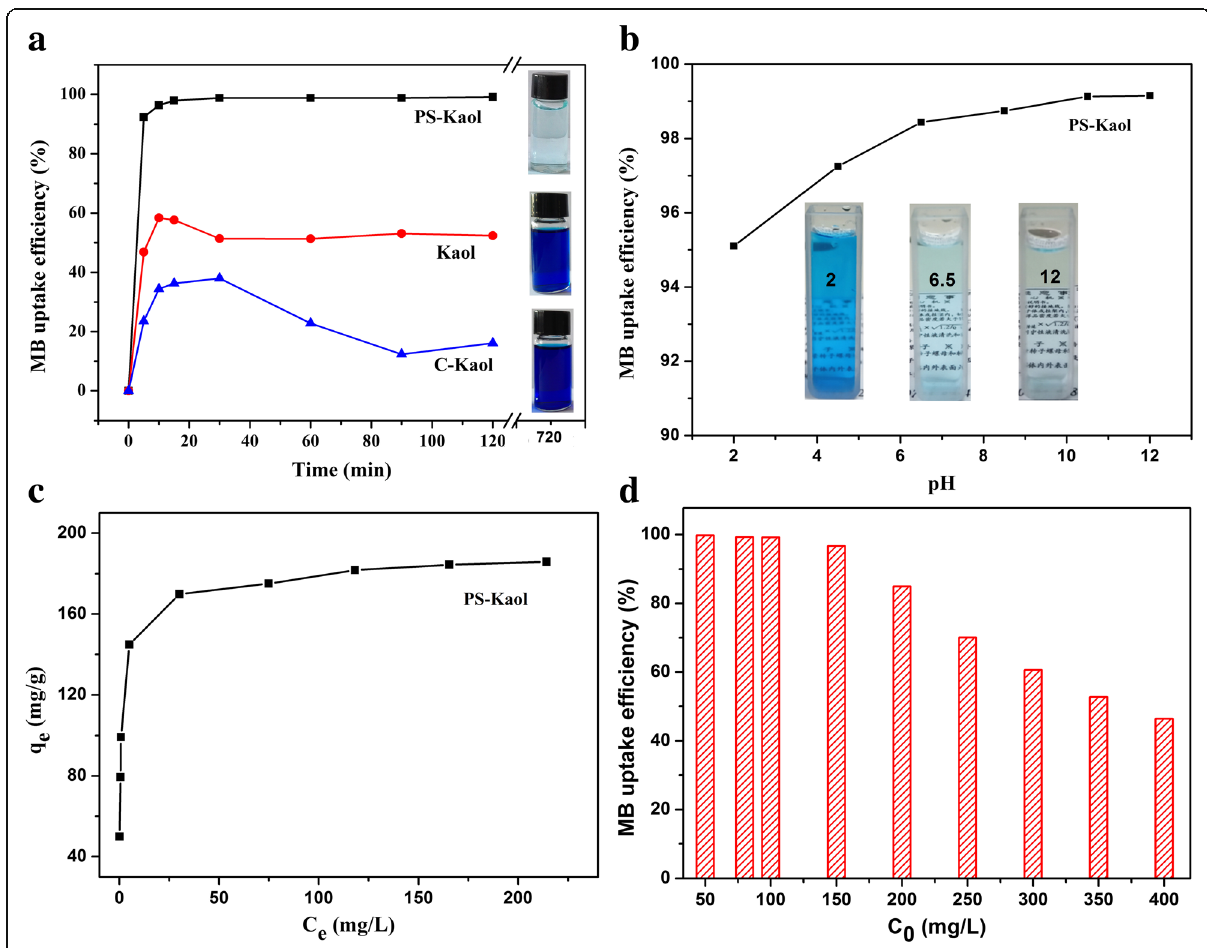
Fig. 4 a Sorption rates of Kaol, C-Kaol, and PS-Kaol samples, 25 °C. b MB uptake efficiency of PS-Kaol sample at various initial solution pH. c Adsorption isotherms of PS-Kaol sample. d MB uptake efficiency of PS-Kaol sample at different initial MB